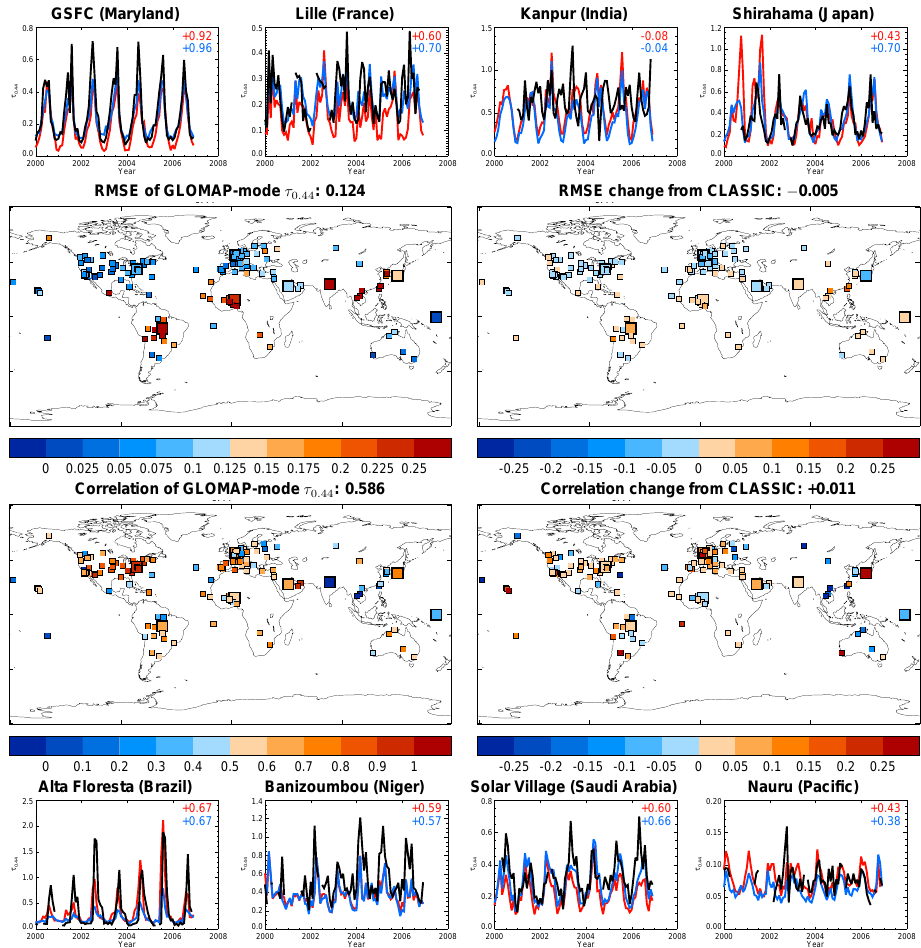
Fig. 3. Top and bottow rows: timeseries of monthly-averaged aerosol optical depths at 0.44µm from AERONET (black), CLASSIC (red), and GLOMAP-mode (blue) for the period 2000–2006 at 8 AERONET sites worldwide. Numbers in the top right corner of each panel shows the correlation between AERONET measurements and CLASSIC (red) and GLOMAP-mode (blue) simulations. Second row, left: map of root mean square error (RMSE) of GLOMAP-mode 2000–2006 timeseries evaluated against observations at 135 AERONET sites. Number in panel title is the RMSE averaged over the 135 AERONET sites. Larger boxes identify the 8 sites shown in the top and bottom rows. Second row, right: map of changes in RMSE due to switching from CLASSIC to GLOMAP-mode aerosol schemes. Third row: as second row, but for the